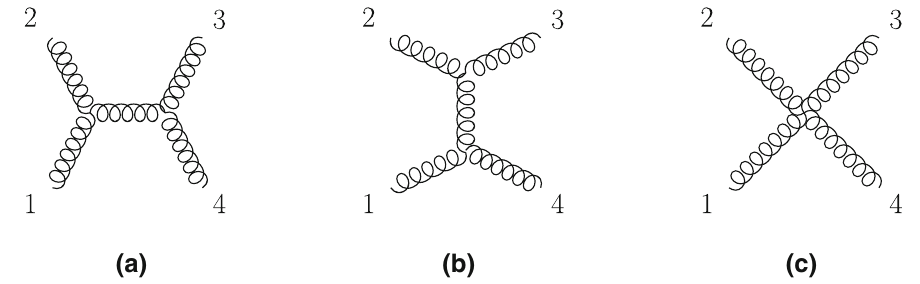
Fig. 3 The three diagrams contributing to the color-partial helicity amplitude M ( 0 → 1 h 1 2 h 2 3 h 3 4 h 4 )